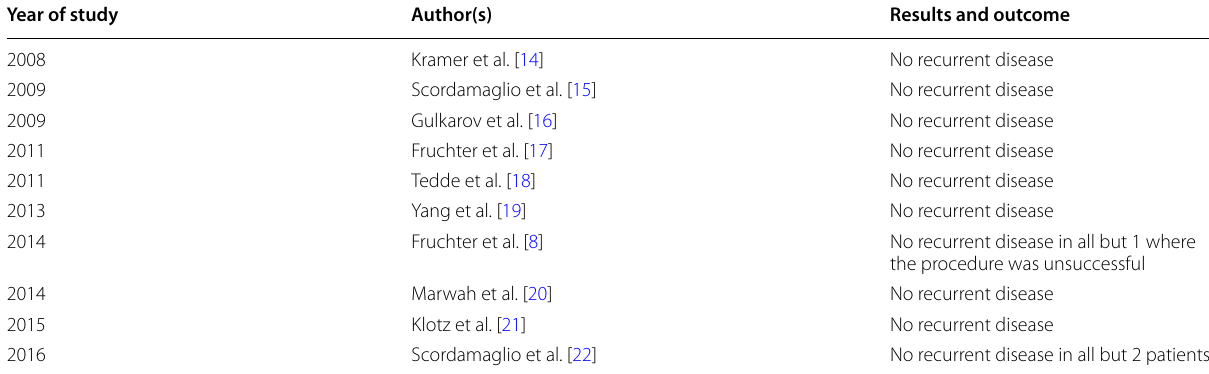
Table 1 Previous studies on the management of BPFs using plug devices Year of study